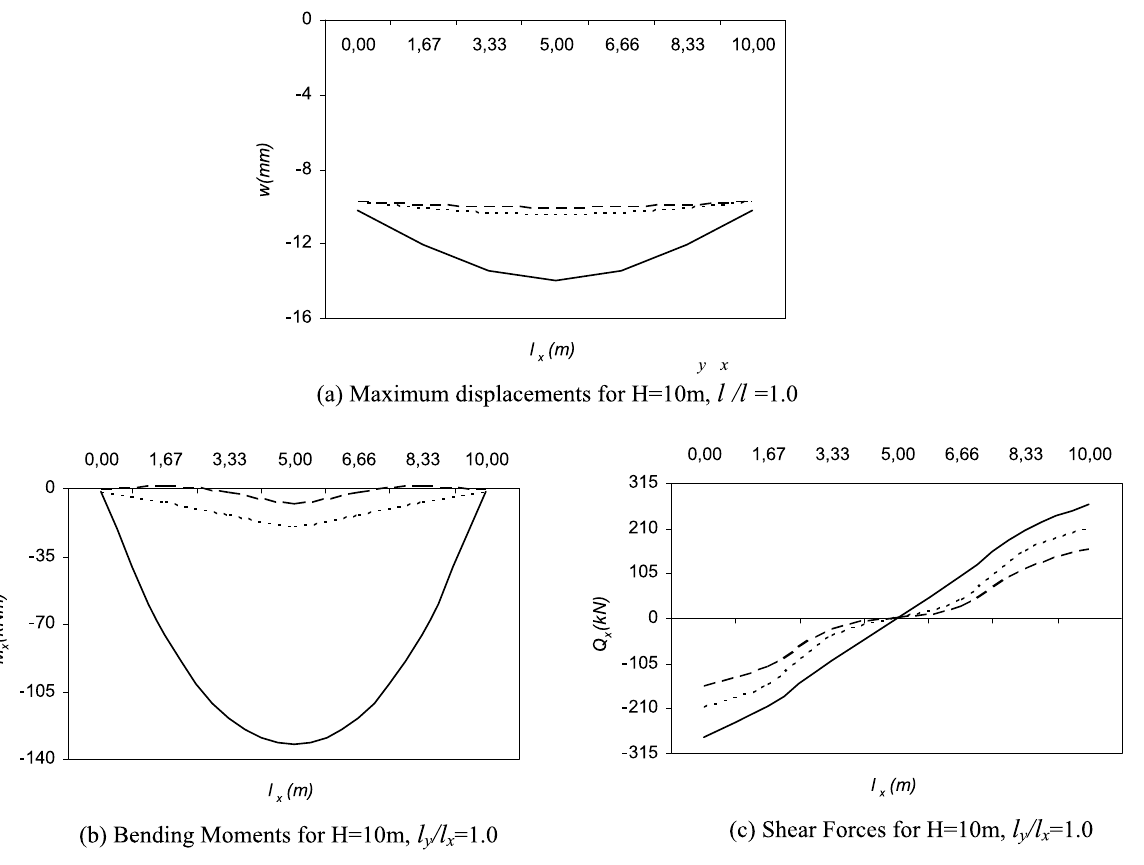
Fig. 9. The variation of the maximum displacement, bending moments and shear forces. –, without beam; ··· , 1.00 × 1.00 beam; —, 1.00 × 1.50